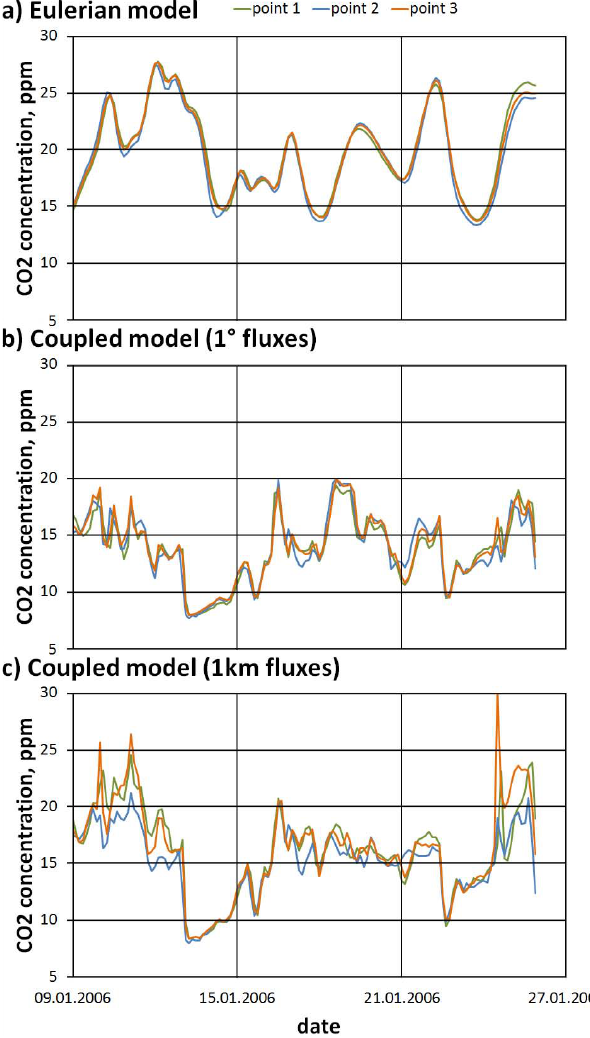
Fig. 1. Results for three imaginary observation sites located east of Moscow. (a) Eulerian model; (b) Coupled model with 1 ◦ resolu- tion; (c) Coupled model with 1-km